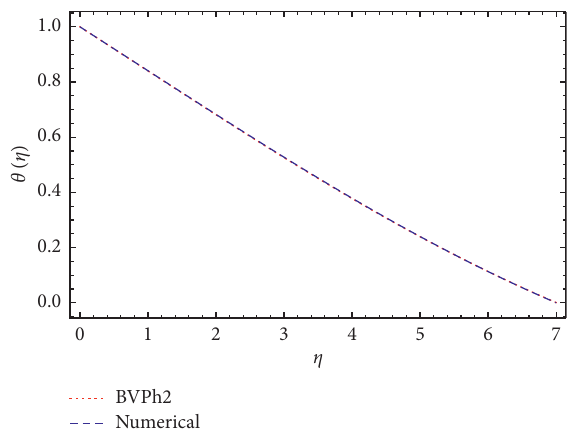
Figure 4: Graphical comparison for two solutions in case of the temperature